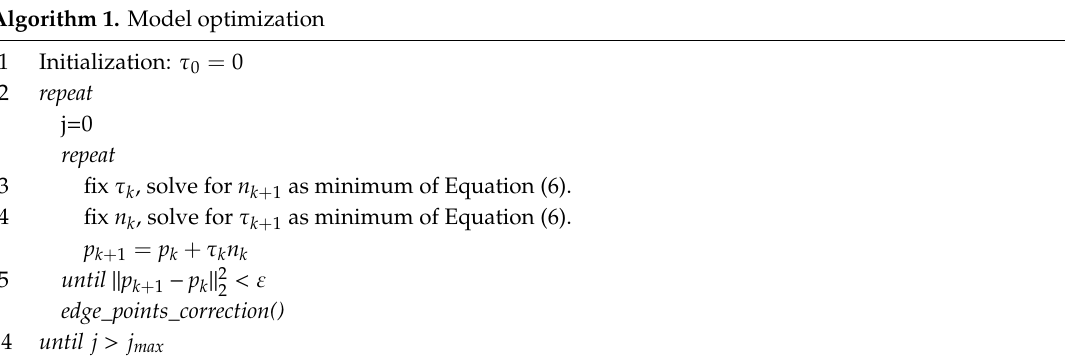
Algorithm 1. Model